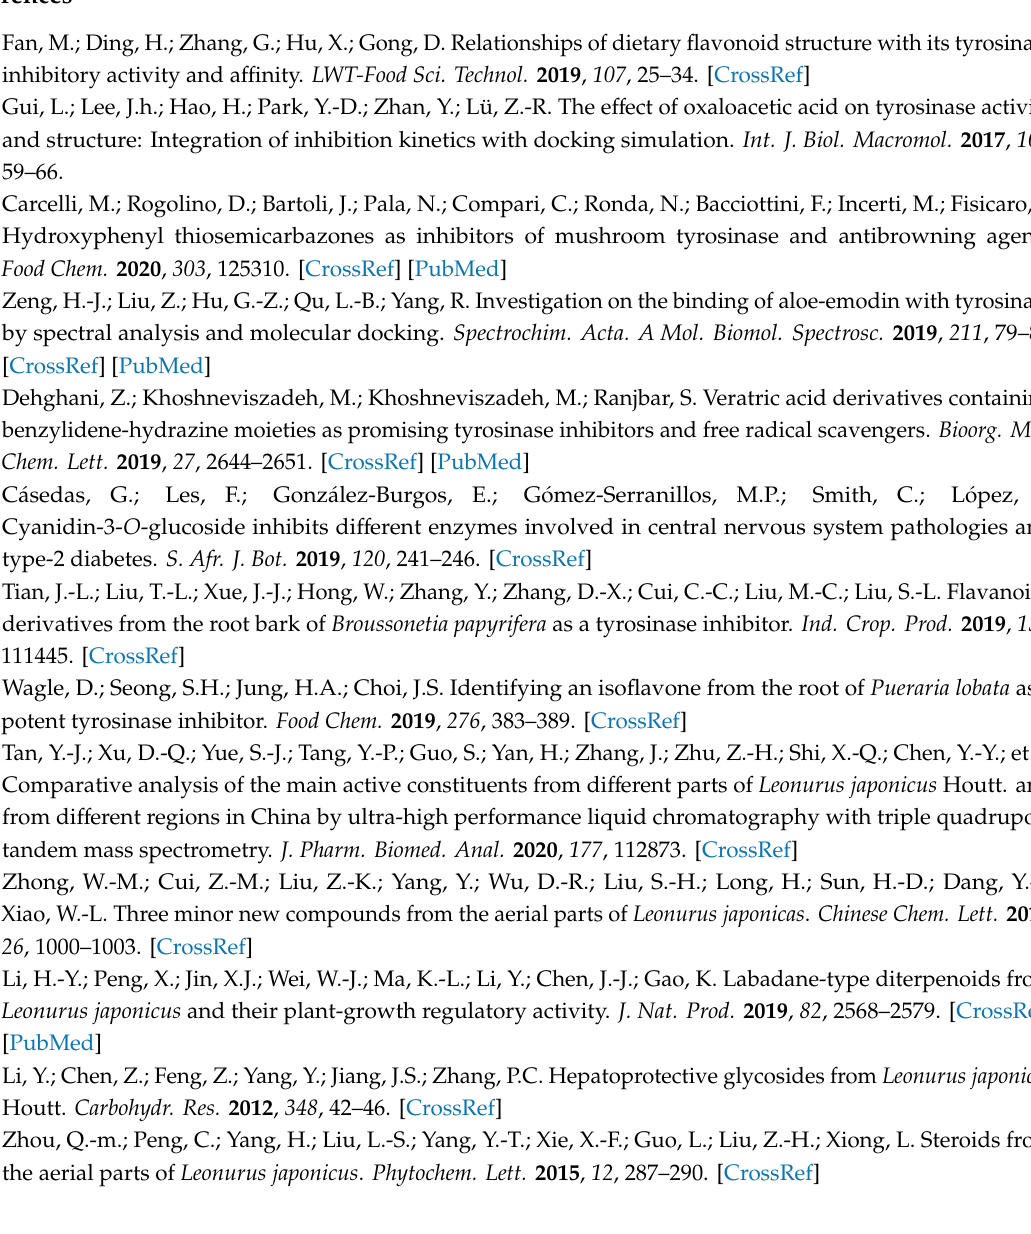
Figure S1–S10: 1 H-NMR, 13 C-NMR spectrum ESI-MS spectrum of compound 1 – 5